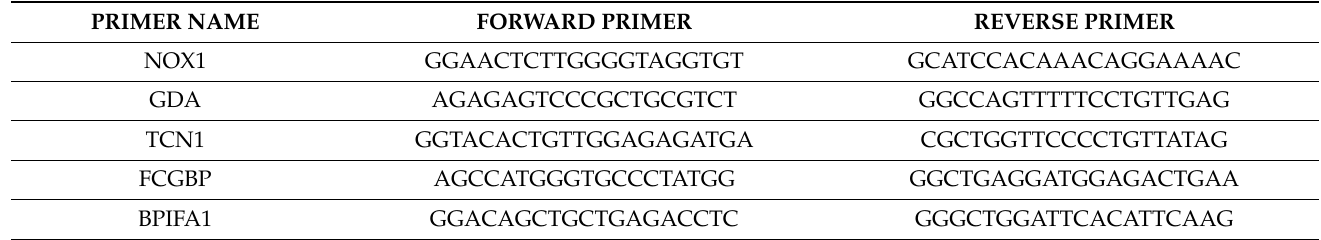
Table 3. List of human primers. NOX1 , NADPH Oxidase 1; GDA , Guanine Deaminase; TCN1 , Transcobalamin 1; FCGBP , Fc Gamma Binding Protein; BPIFA1 , BPI Fold Containing Family A Member 1; AZGP1 , Alpha-2-Glycoprotein 1; CFB , Complement Factor B; VTCN1 , V-Set Domain Con- taining T Cell Activation Inhibitor 1; AGR3 , Anterior Gradient 3; CTS1 , chimeric tumor suppressor 1; F5 , Coagulation Factor V; CEACAM6 , CEA Cell Adhesion Molecule 6; BPIFB1 , BPI Fold Containing Matrix metalloproteinase 2; and GAPDH , Glyceraldehyde 3-phosphate